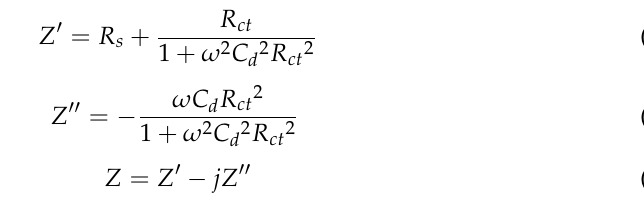
Figure 2. The EIS responses of MIPs/dsDNA sensor under different conditions in 0.005 mol/L of K 4 [Fe(CN) 6 ]/K 3 [Fe(CN) 6 ] (contain 0.1 mol/L KCl) solution over the frequency range from 0.1 Hz to